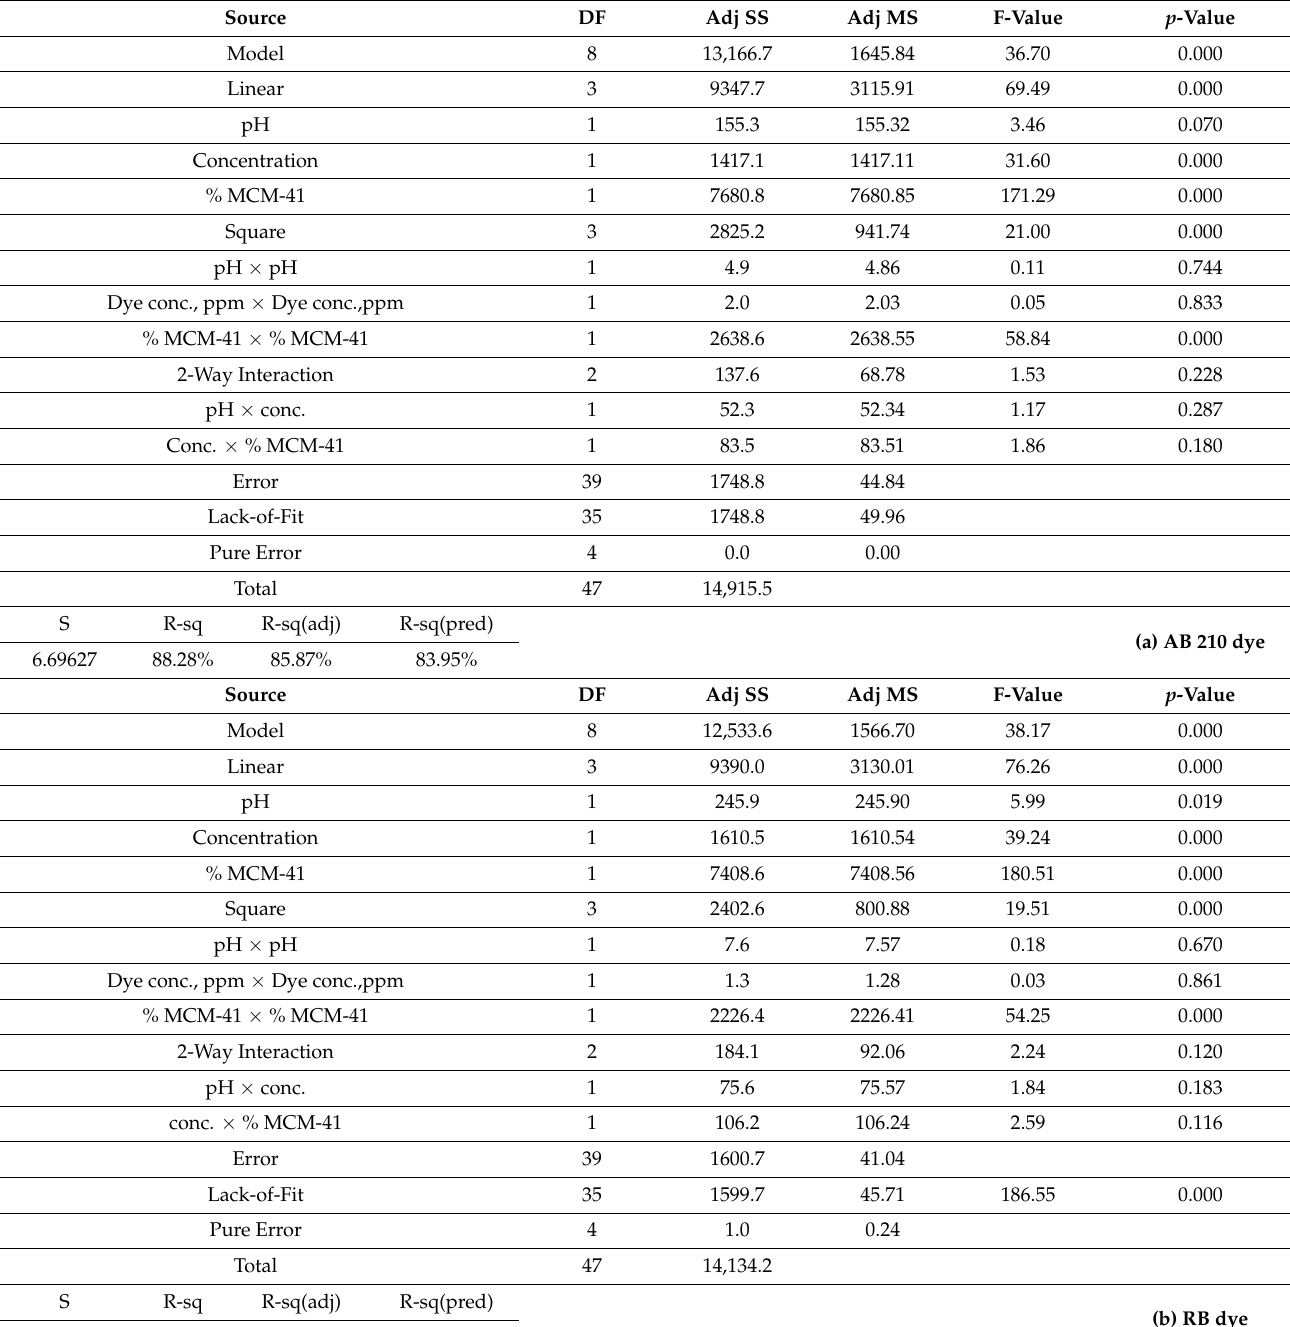
Table 4. Analysis of variance (ANOVA) for the permeability of (a) AB-210, and (b) RB